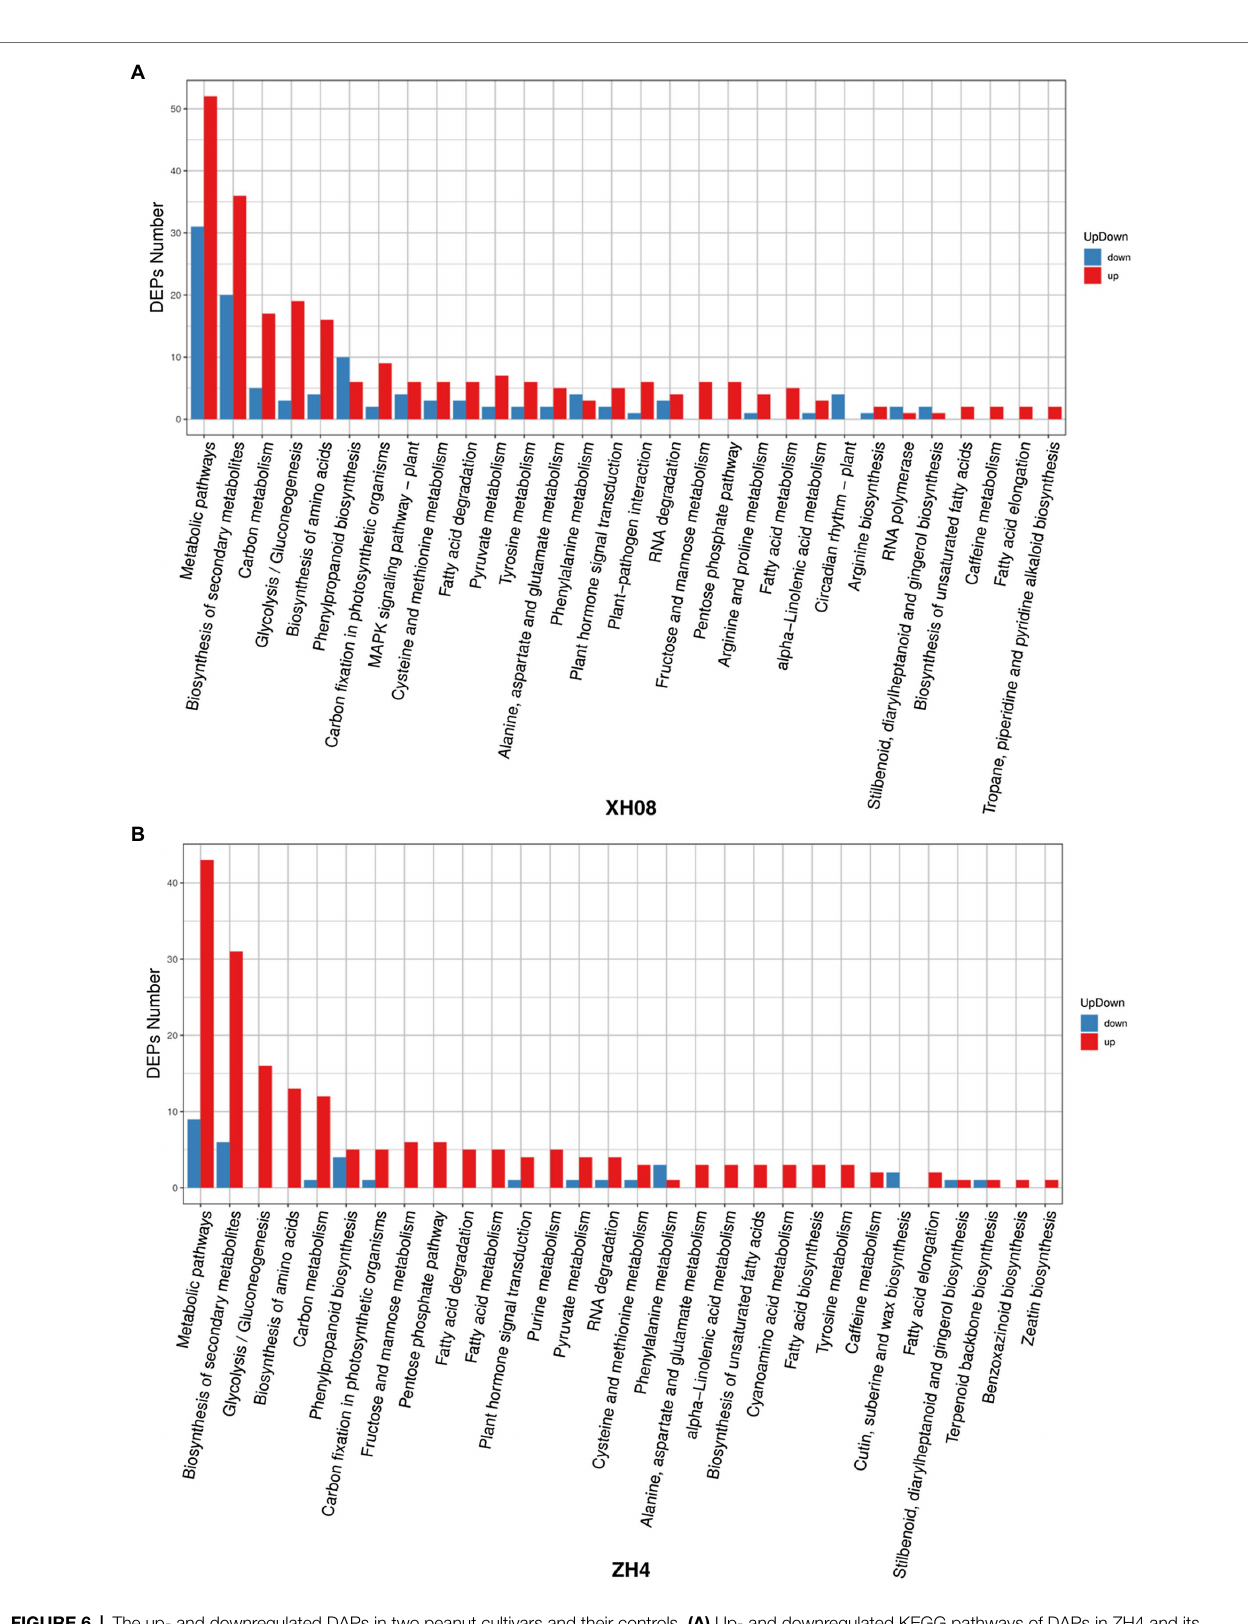
FIGURE 6 | The up- and downregulated DAPs in two peanut cultivars and their controls. (A) Up- and downregulated KEGG pathways of DAPs in ZH4 and its controls; (B) up- and downregulated KEGG pathways of DAPs in XH08 and its